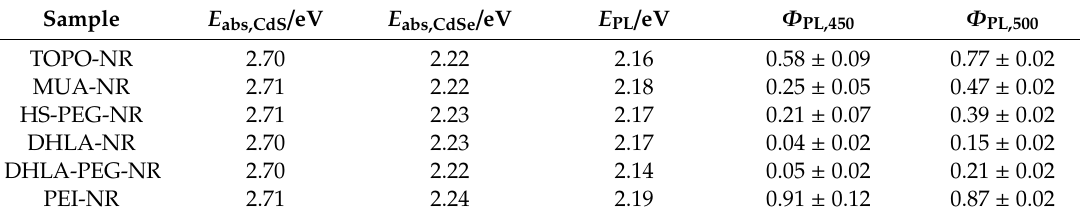
Table 1. Steady-state absorption and photoluminescence data of NR with di ff erent surface ligands in pure water, TOPO-NR in toluene: E abs,CdS and E abs,CdSe spectral position of the lowest energy excitonic CdS and CdSe seed absorption peak position, E PL spectral position of the peak photoluminescence upon excitation at 3.10 eV (400 nm), and the absolute photoluminescence quantum yields Φ PL,450 and Φ PL,500 upon excitation at 2.76 eV (450 nm) and 2.48 eV (500 nm), respectively. For equal to the instrumental